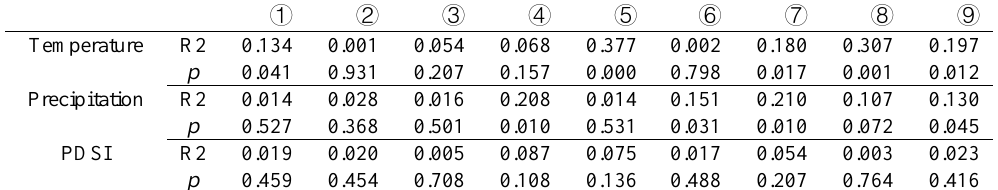
Table S5. The statistical report of the correlation between NDVI and climate variables in terms of nine major crop zones. where ① ~ ⑨ represent the Central Eur_Rus zone, East China zone, North America zone, South Australia zone, Southeast Latin America zone, West Latin America zone, Southwest Africa zone, Southwest Asia zone, and West Europe zone,